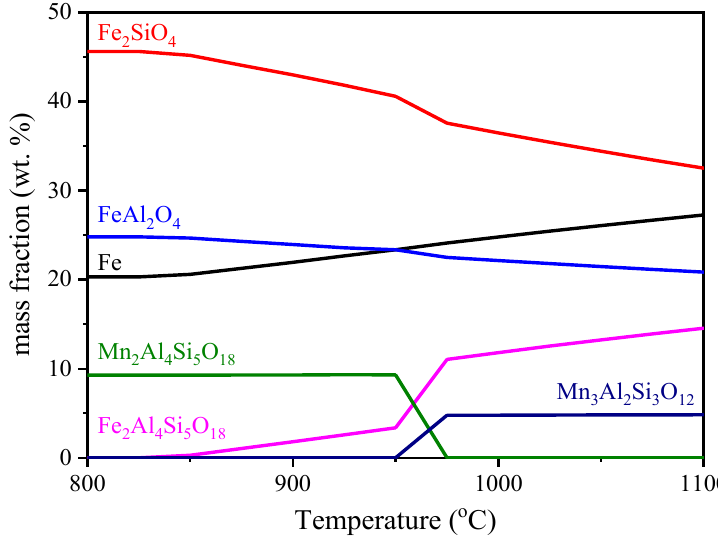
Figure 10. Thermodynamic simulation of a system consisting of Fe 2 O 3 , CO, SiO 2 , Al 2 O 3 and MnO carried out between 800 °C and 1100 °C in CO atmosphere at ambient pressure.